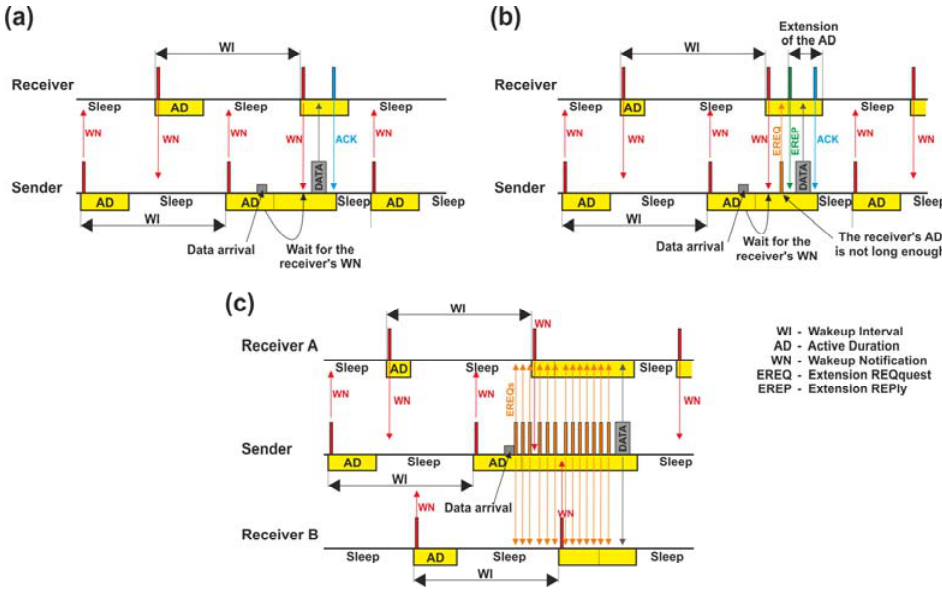
Figure 5. Examples of ASES transmission: ( a ) unicast without extending the receiver’s AD; ( b ) unicast by extending the receiver’s AD; and ( c )